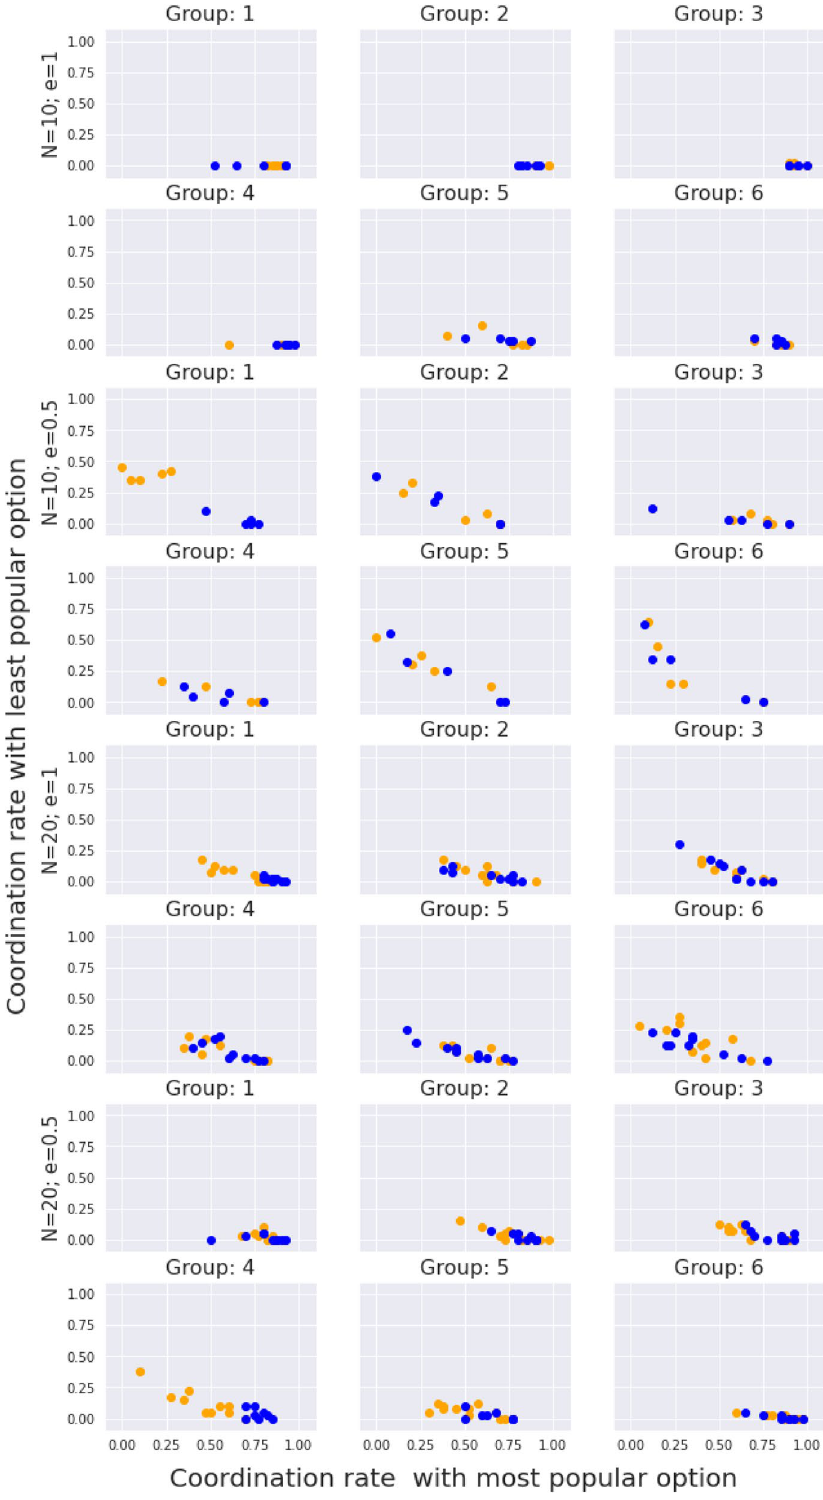
Figure 2. Experimental profiles of coordination rates for the transient (rounds 0 to 40); X-axis: coordination rate within the subpopulation that shared the most popular action in the population; Y-axis: coordination rate within the subpopulation that shares the complementary action. Coloured, the marker of the